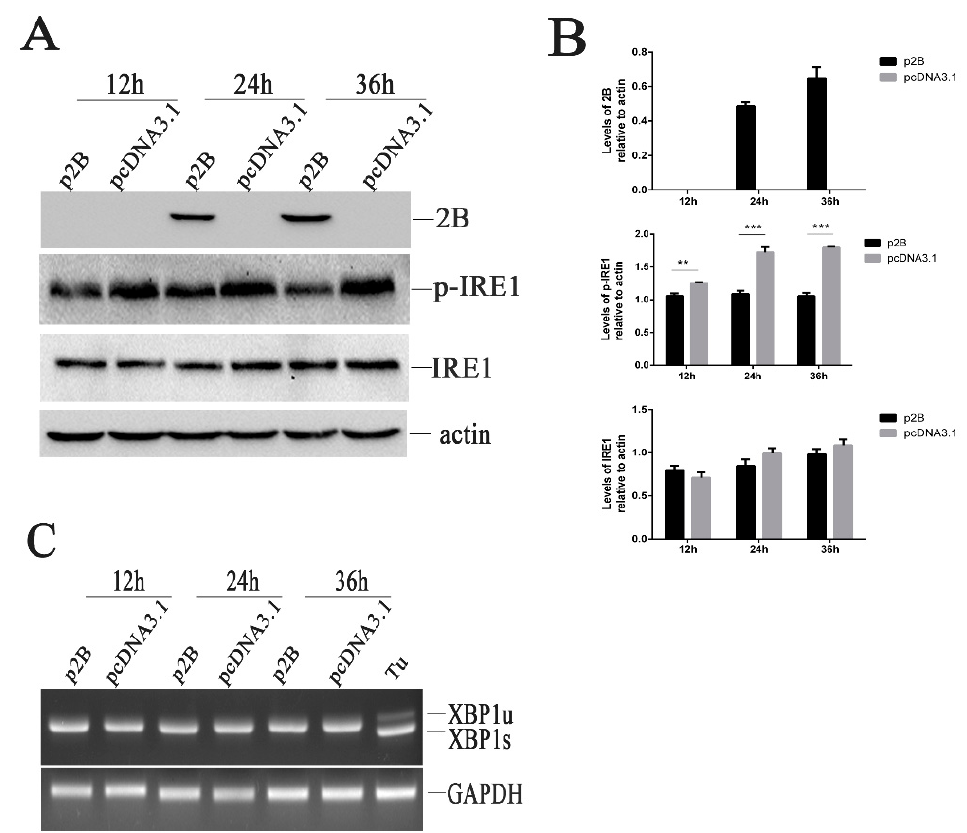
Figure 6. HRV16 2B dephosphorylates p-IRE1 protein. ( A ) H1-HeLa cells were transfected with p2B or pcDNA3.1 for 12 h, 24 h and 36 h. The time course of the 2B, p-IRE1 and IRE1 proteins was detected by Western blotting. β -actin was used as a control. ( B ) Histogram of gray scanning analyses of the 2B, p-IRE1 and IRE1 protein bands of Figure 5A relative to actin is shown, respectively. The error bars represent the mean SD of three independent experiments. Statistical differences compared with controls are illustrated as * p < 0.05, ** p < 0.01, and *** p < 0.001. ( C ) H1-HeLa cells were transfected with p2B or pcDNA3.1 for 12 h, 24 h and 36 h. The time course of XBP1 mRNA expression was detected by RT-PCR. “Tu” represents cells treated with 1.0 µ g/mL tunicamycin.